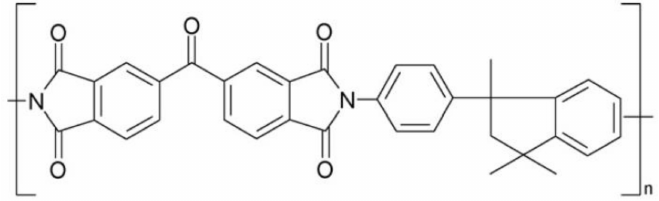
Figure 2. Chemical structure of Matrimid ®